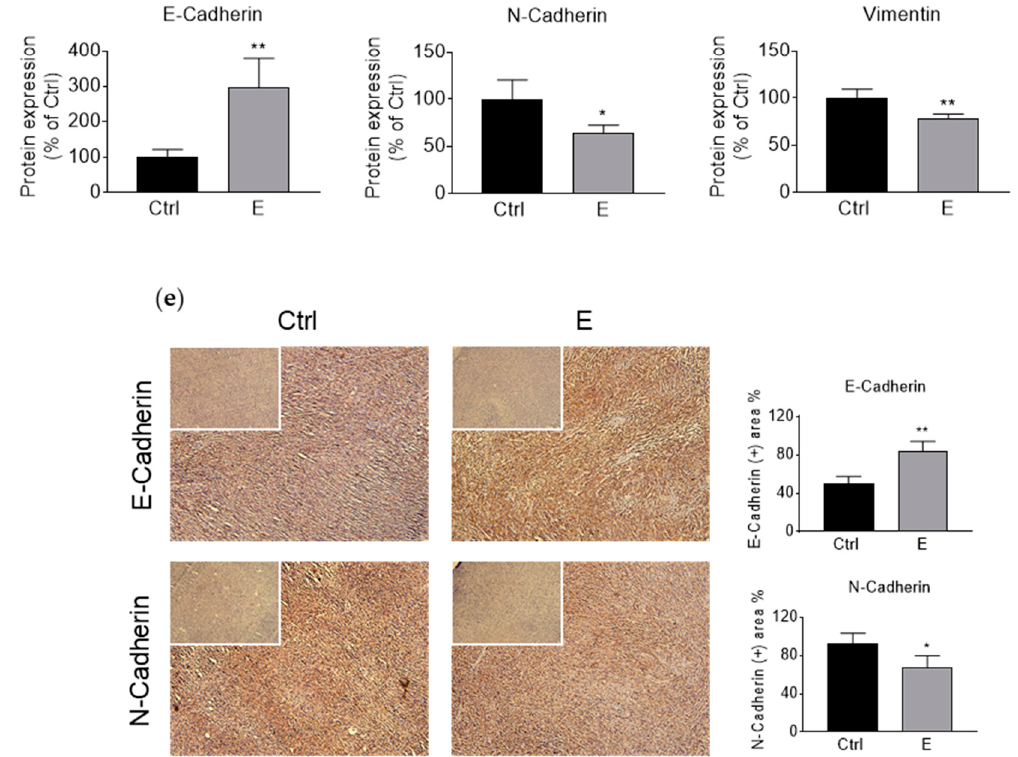
Figure 2. EGCG inhibits cell motility, migration and invasion in pancreatic cancer cells. ( a ) Wound healing assays were performed in Panc-1 and MIA PaCa-2 cells treated without (control) or with EGCG for 48 h. Images were visualized at time 0 h and 48 h. Quantitative analysis was conducted as described under Materials and Methods. Results are expressed as the percentage of control. ** p < 0.01 vs. control. ( b ) E ff ect of EGCG on cell migration and invasion was determined by using the inserted cartridge with or without matrigel. Briefly, Panc-1 and MIA PaCa-2 cells were treated without (control) or with EGCG for 48 h. Cells were seeded in the upper compartment of a migration or invasion chamber in serum-free culture media. After 48 h, cells that remained in the upper chamber were removed and cells that had migrated (left) or invaded (right) onto the lower surface of the membrane were fixed and stained with crystal violet. Representative images are shown ( × 200). The relative-fold migration and invasion values of EGCG-treated cells were normalized against the vehicle-treated cells (control) and expressed as percentage of control, which was assumed to be 100 percent. ** p < 0.01 vs. control. ( c ) EGCG inhibits cell migration and invasion through modulating EMT in pancreatic cancer cells. Immunoblots for E- Cadherin, N-Cadherin, TCF8 / ZEB1, β -Catenin, and Vimentin in total cell protein extracts from Panc-1 and MIA PaCa-2 cells treated with escalating concentrations of EGCG, as indicated, for 48 h. Loading control: β -Actin. Bands were quantified and results are expressed as a percentage of control. * p < 0.05, ** p < 0.01 vs. control. ( d ) EGCG a ff ects epithelial–mesenchymal transition (EMT) protein expression in vivo. Immunoblots for E-Cadherin, N-Cadherin, and Vimentin of tumor samples obtained from EGCG-treated mice. β -Actin was evaluated as the loading control. Each lane represents a di ff erent tumor sample. Bands were quantified and results are expressed as a percentage of control. * p < 0.05, ** p < 0.01 vs. control. ( e ) Tumor tissue sections were immunohistochemically stained with E-cadherin and N-cadherin. The consecutive section was stained with isotype IgG as negative staining control and shown in the upper left corner of each image. Results were quantified based on the intensity of each field and expressed as percent of E / N-Cadherin positive area per field. Images were taken at × 100. * p < 0.05, ** p < 0.01 vs.